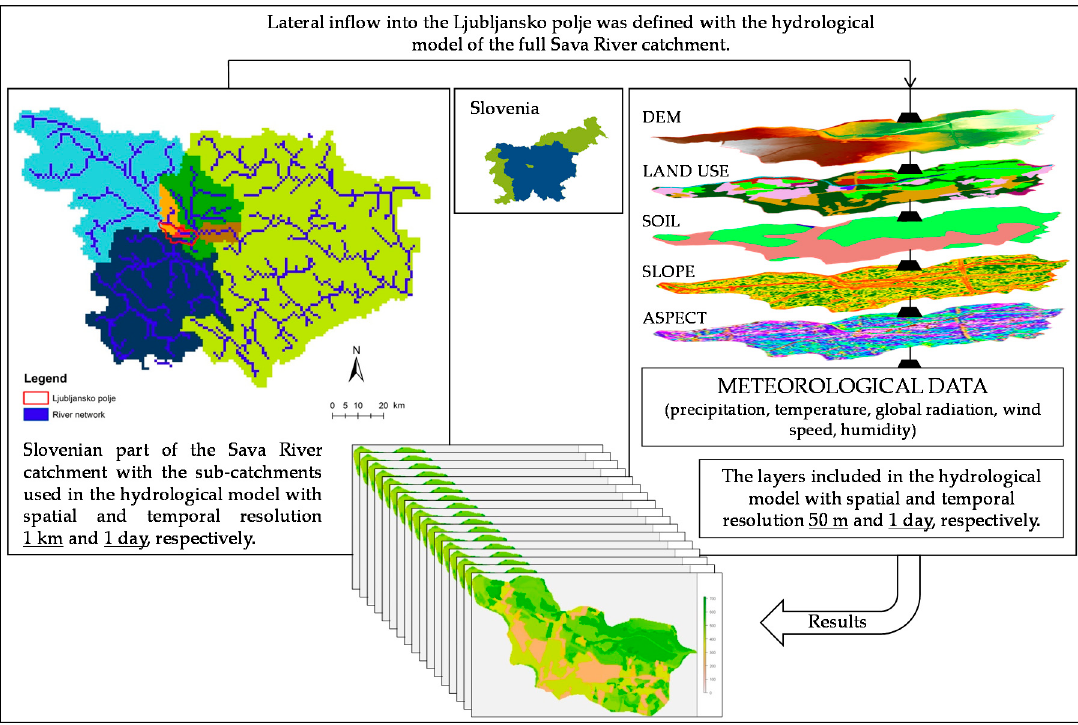
Figure 4. A framework of the modeling procedure with WaSiM.